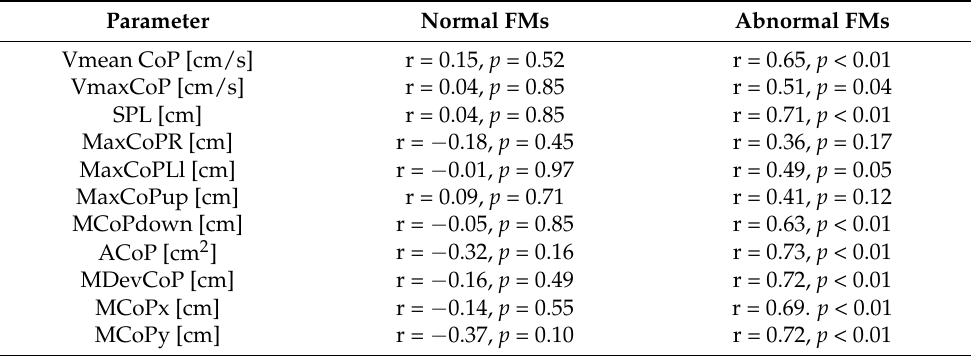
Table 7. Pearson’s correlations between CoP parameters in PT in prone and supine positions in the groups of infants with normal versus abnormal